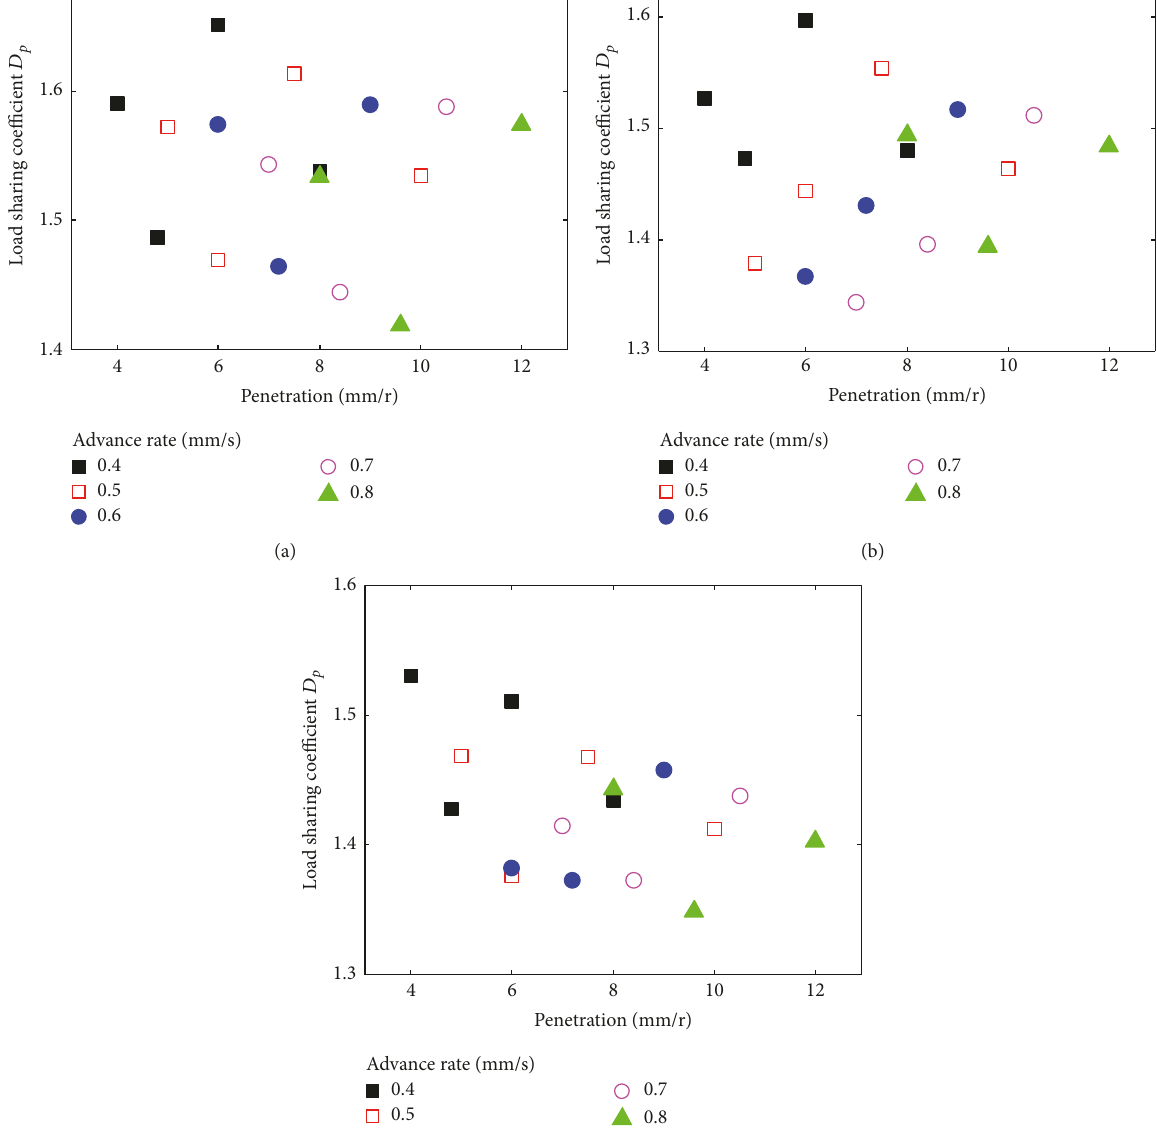
the performance evaluation of hard rock TBMs presented in this